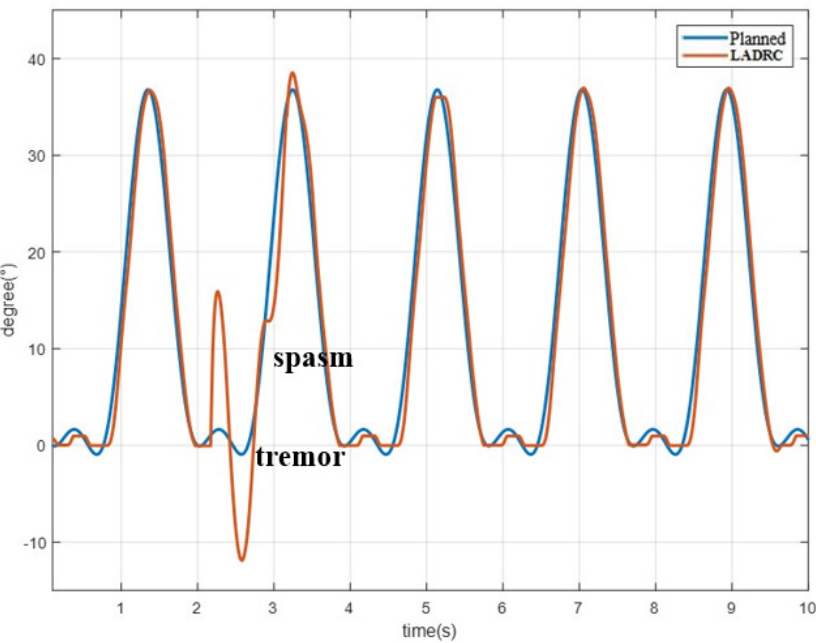
Figure 12. Trajectories of hip joint by LADRC with spasm and tremor occurring at walking speed = 0.225 m/s.